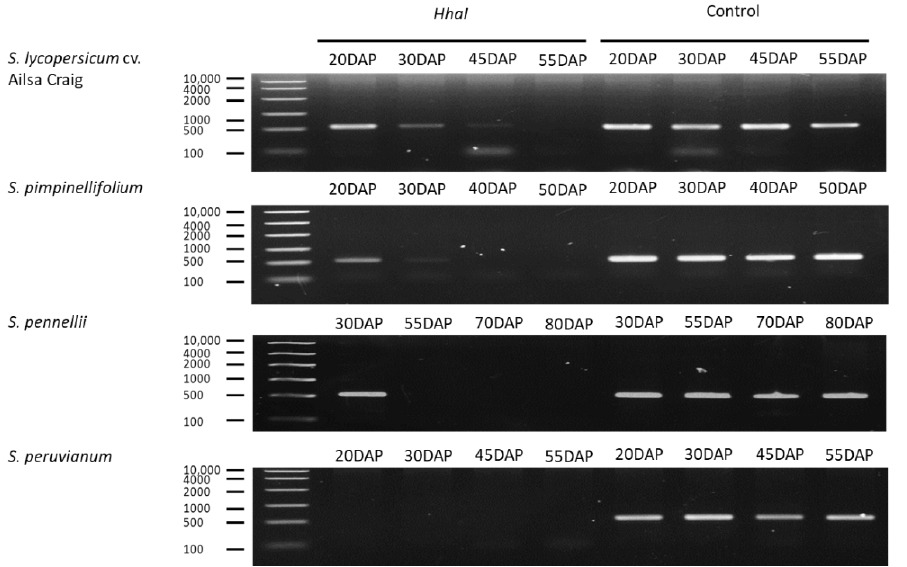
Figure 5. Analysis of DNA methylation by qAMP in upstream regions of NOR . Levels of methyla- tion change over time. DAP: days after